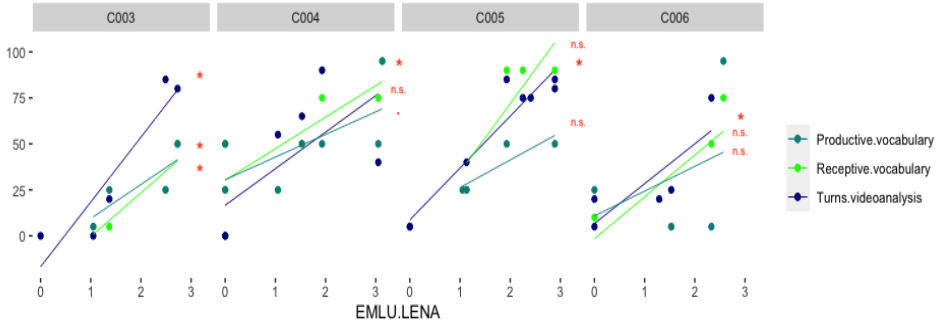
Figure 1. Percentile scores for Productive and Receptive vocabulary, and the percentage of vocal conversational turns estimated from video analysis as measured at different EMLU. The lines represent the linear regression estimates between each variable and the EMLU from LENA.